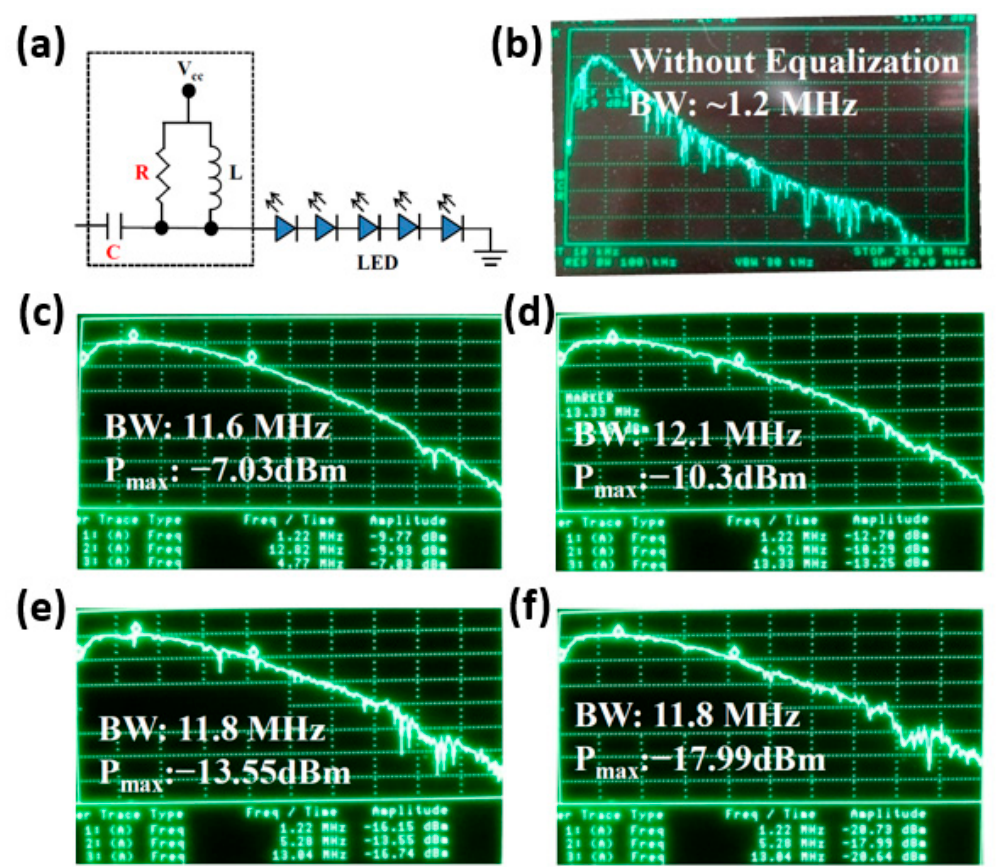
Figure 14. ( a ) Resistance-Inductance-Capacitance (RLC) circuit design for pre-equalization technology; ( b ) bandwidth of phosphor-LED without pre-equalization. The 3dB bandwidth of phosphor-LED with pre-equalization under received power of ( c ) 1100; ( d ) 900; ( e ) 700; ( f ) 500 Lux, respectively. [91] Figures reproduced with permission from Optical Society of America.